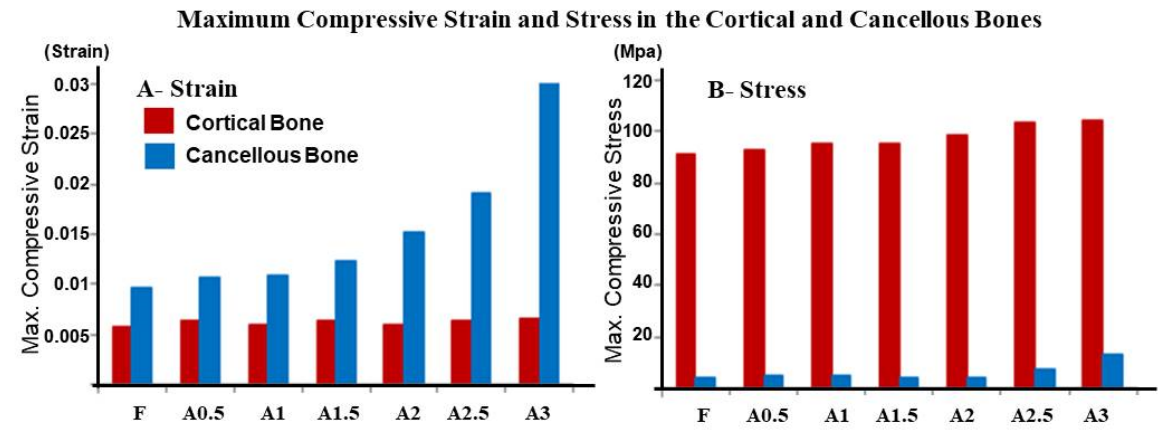
Figure 2. Maximum compressive strain ( A ) and stress ( B ) in the cortical (red bars) and cancellous (blue bars) bones in the fenestration (F) and augmented model (A0.5–A3).